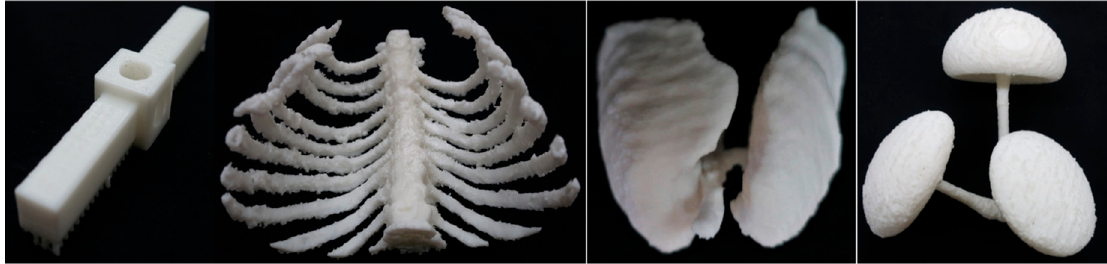
Figure 9. Images of the printed objects; stick, bone, lung, and mushroom (from left to right).